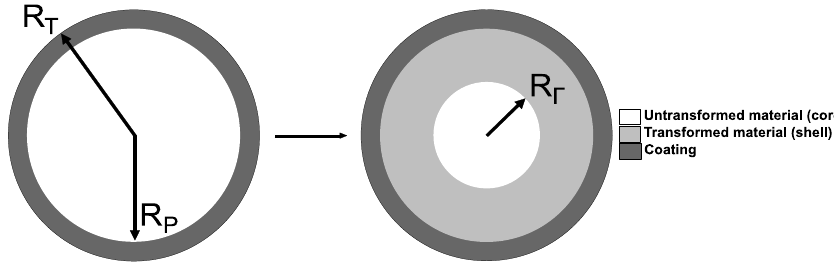
Figure 1. Spherical polymer-coated Si particle undergoing a two-phase lithiation process (the lithiated particle is shown as mapped onto the reference (undeformed) configuration); coating thickness h = R T − R P ; R Γ denotes the position of the reaction front mapped onto the reference (undeformed) configuration.